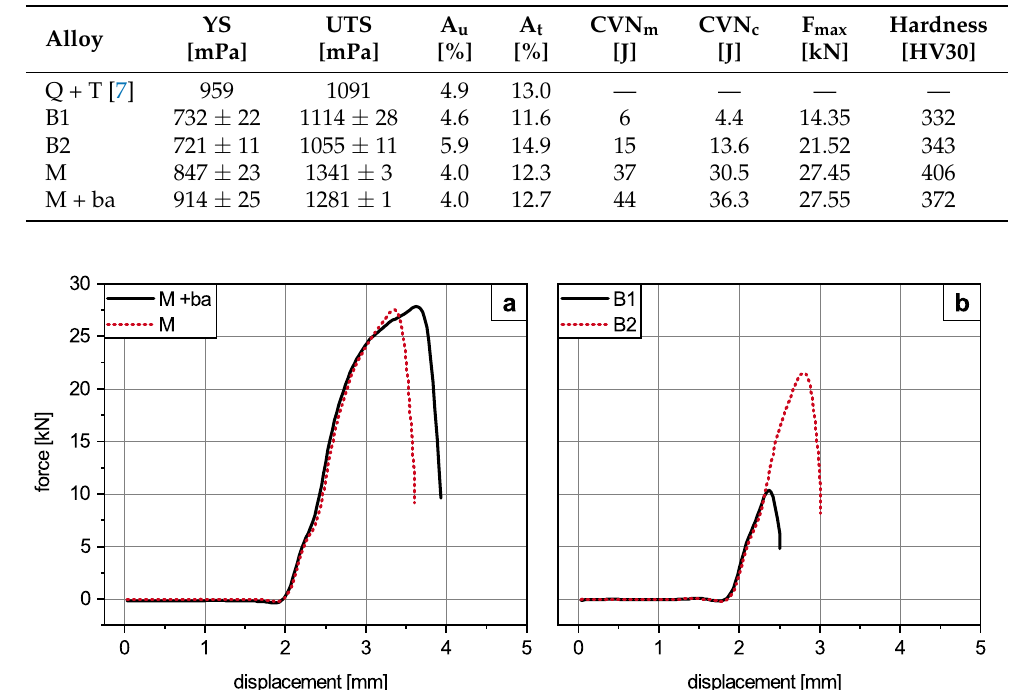
Table 3. Mechanical properties obtained by tensile tests, hardness measurements, and instrumented Charpy V-notch tests.